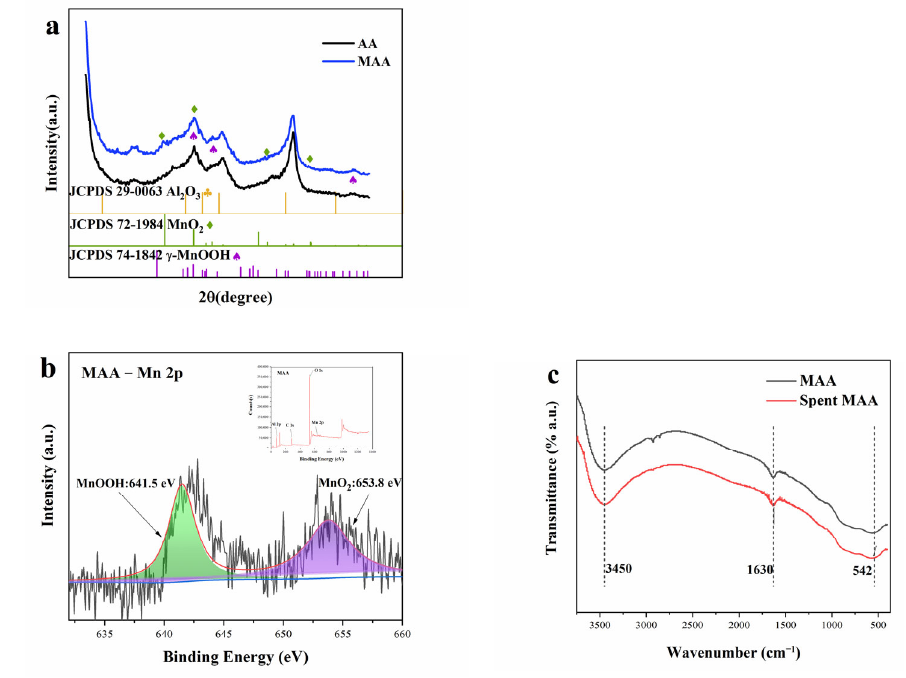
Figure 3. XRD analysis of fresh alumina and MAA ( a ); XPS spectra of Mn 2p for MAA ( b ); FT-IR spectrum of fresh alumina and MAA ( c ).